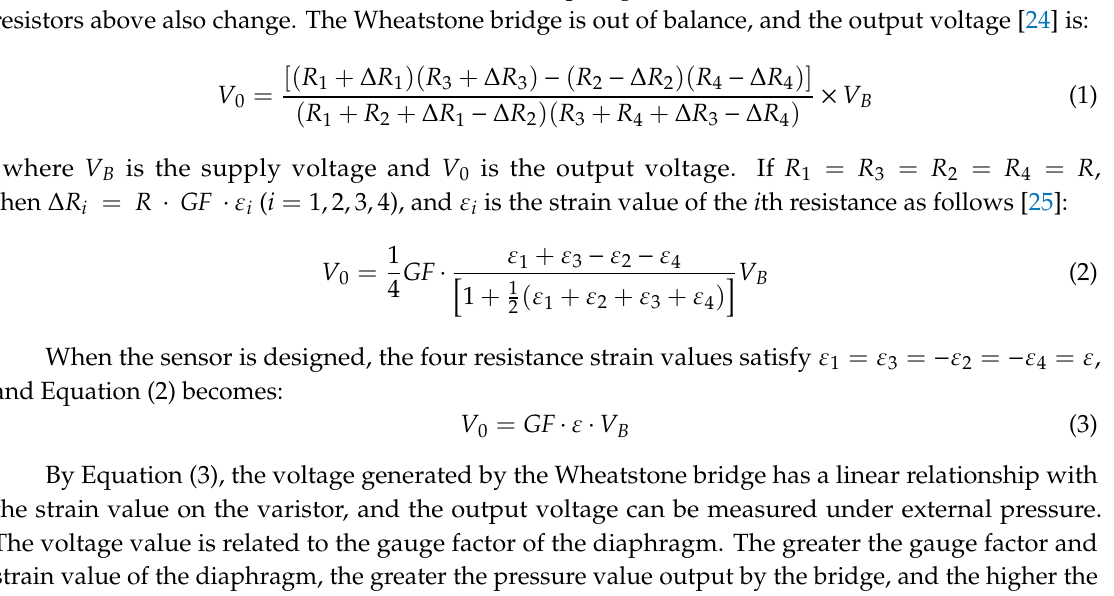
Figure 2. Wheatstone bridge circuit.